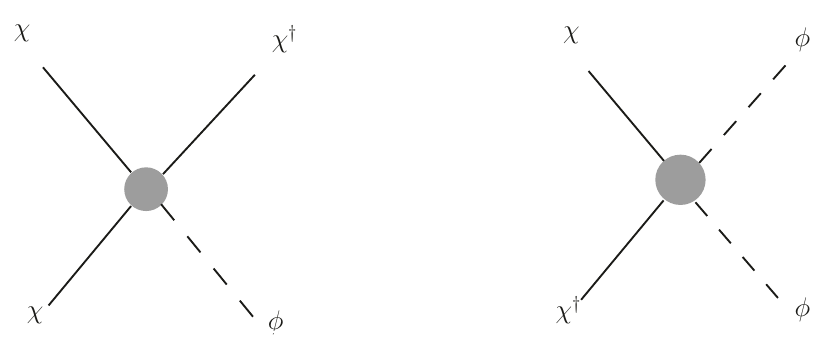
Figure 1 . E(cid:11)ective interactions for the semi-annihilation (left) and pair-annihilation (right) pro- cesses. The former violates DM number by three units (and hence can generate a DM anti-DM asymmetry), while the latter conserves DM